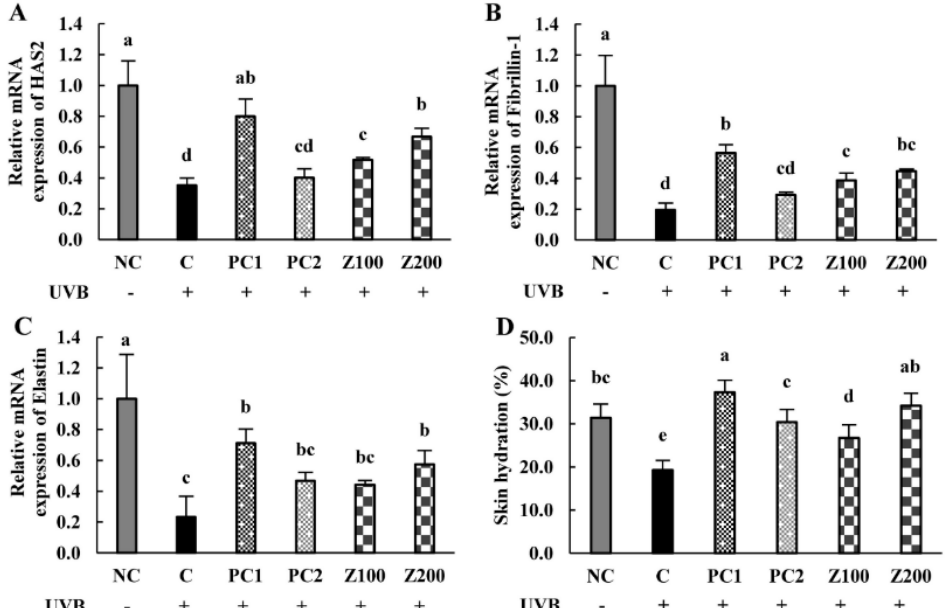
Figure 2. Effects of FSH-ZM on the expression of mRNAs related to skin moisturizing and skin hydration content in skin from the back of UVB-irradiated HRM-2 hairless mice. ( A ) The expression of HAS2 mRNA. ( B ) The expression of Fibrillin-1 mRNA. ( C ) The expression of Elastin mRNA. ( D ) Skin hydration. NC, normal control; C, UVB-irradiated control; PC1, positive control 1, L-ascorbic acid 200 mg/kg b.w.; PC2, positive control 2, Arbutin 200mg/kg b.w.; Z100, FSH-ZM 100 mg/kg b.w.; Z200, FSH-ZM 200 mg/kg b.w. Values are presented as mean ± standard deviation (n = 6), and different superscript letters indicate significance at p < 0.05.